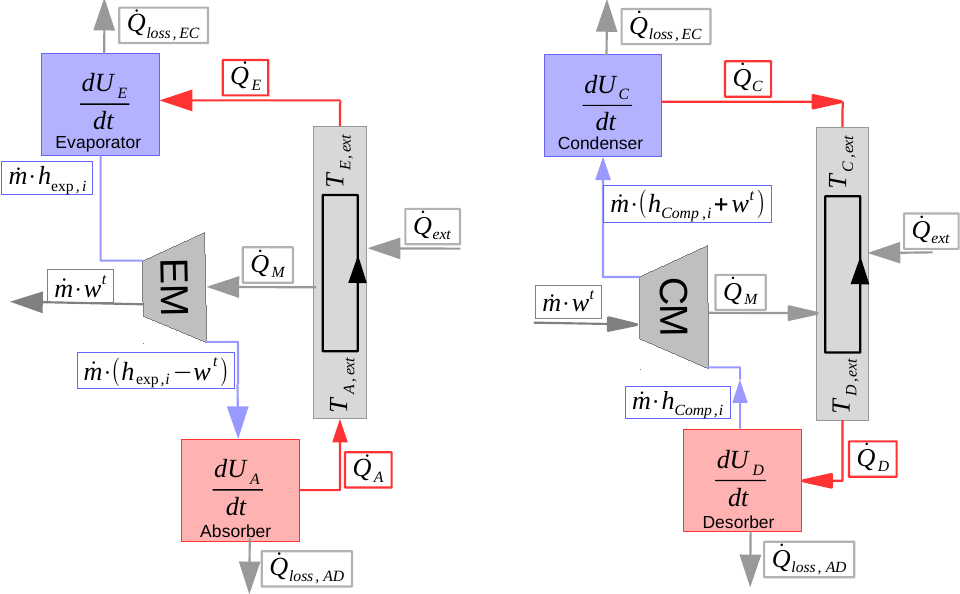
Figure 5. System configuration (C): Indirectly coupled HXs and heated/cooled expansion/compression machine—mechanical discharging ( left ), mechanical charging ( right